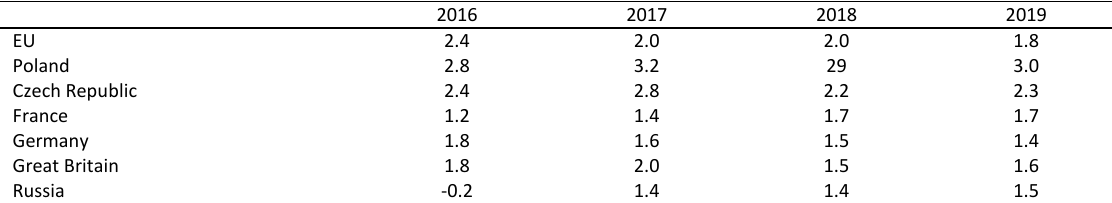
Table 1: The forecasts for the GDP growth in selected countries (%) (IMF, 2018; DESAMA, EU